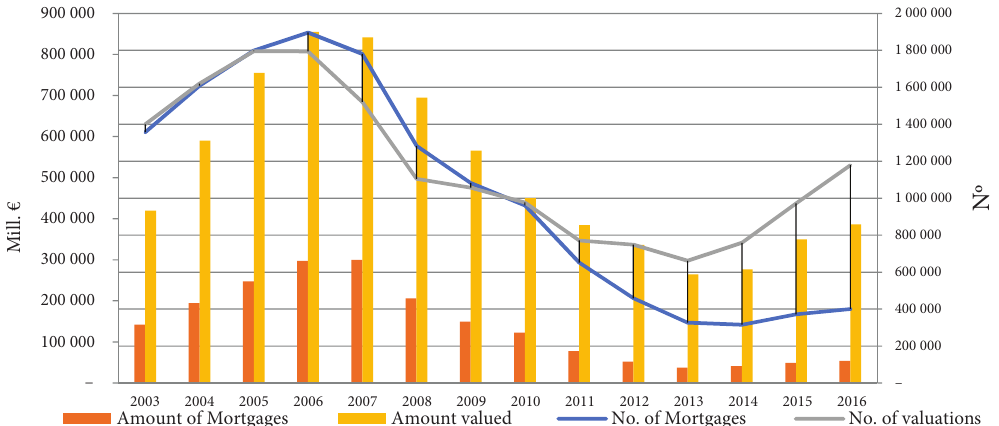
Figure 1. Evolution of mortgage activity and valuations in